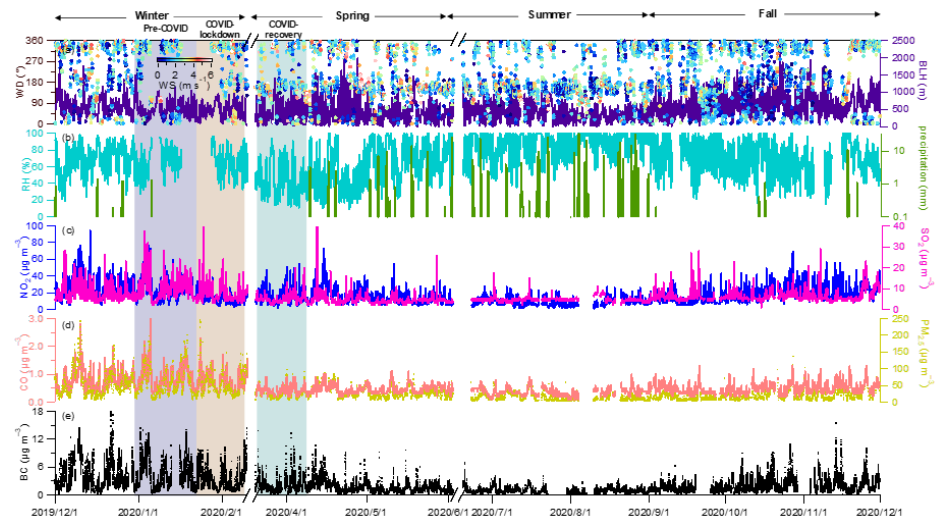
Figure 1. Time series of ( a ) wind direction (WD) colored by wind speed (WS), boundary layer height (BLH), ( b ) relative humidity (RH) and precipitation; mass concentrations of ( c ) SO 2 , NO 2 , ( d ) CO, PM 2.5 , and ( e ) atmospheric black carbon (BC) during the whole observation in Qingdao. Three trans- parent colors represent the three periods regarding the COVID-19 epidemic for further discussion.